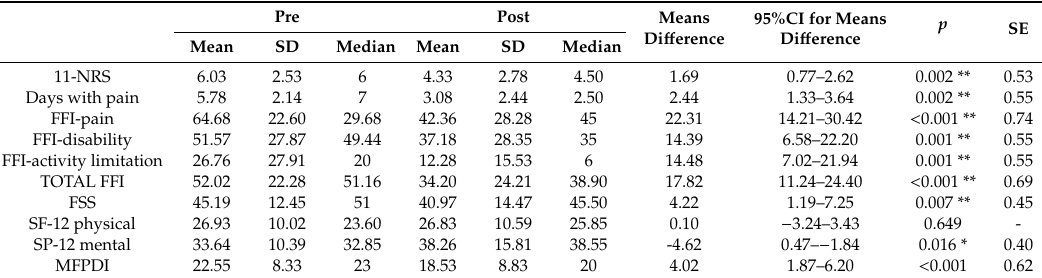
Table 4. Intervention